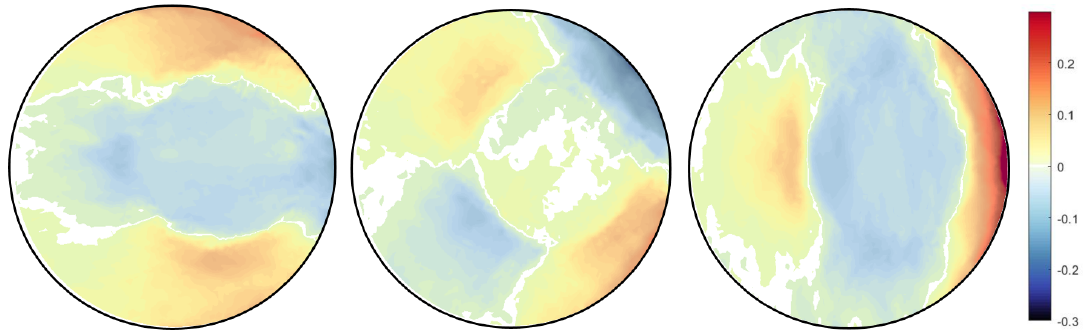
Figure 12. Regularised strain field ε xx , ε xy , ε yy respectively for unstructured mesh type with S as stiffness matrix and α =